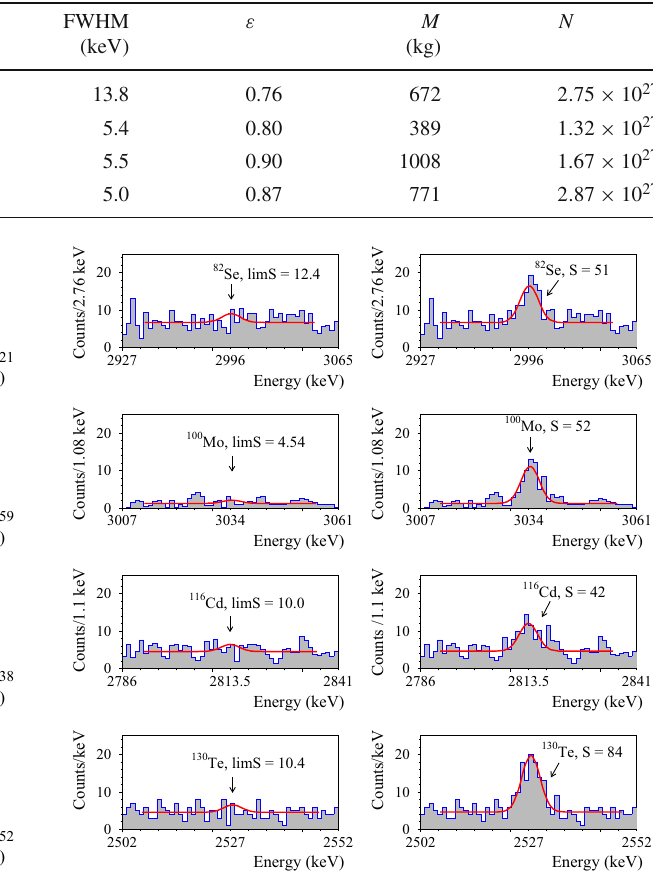
Fig. 1 Generated energy spectra for Zn 82 Se, Li 100 MoO 4 , 116 CdWO 4 Fig. 2 ThesamespectraasinFig.1arereported,butbinningisinunits 2 and 130 TeO 2 detectors for the CUPID-1 option, assuming the back- of energy resolution (1 bin = FWHM(keV)/5). This approach leads to ground simulated in Ref. [44] (see also text and Table 1 for details). a slightly better sensitivity, as discussed in the text The figures at the left column show the “no effect observed” case, while thoseattherightcolumnillustratetheeffectsforaneutrinomassof0.05 eV calculated with the matrix elements from Ref. [46], the phase space Values of S and σ( S ) can be estimated by using formula factors from Ref. [47] and the value of the axial vector coupling con- (5) and by a fit of the sum spectrum of several stant g A = 1 . 27. Values of the excluded lim S and peaks areas S are in counts